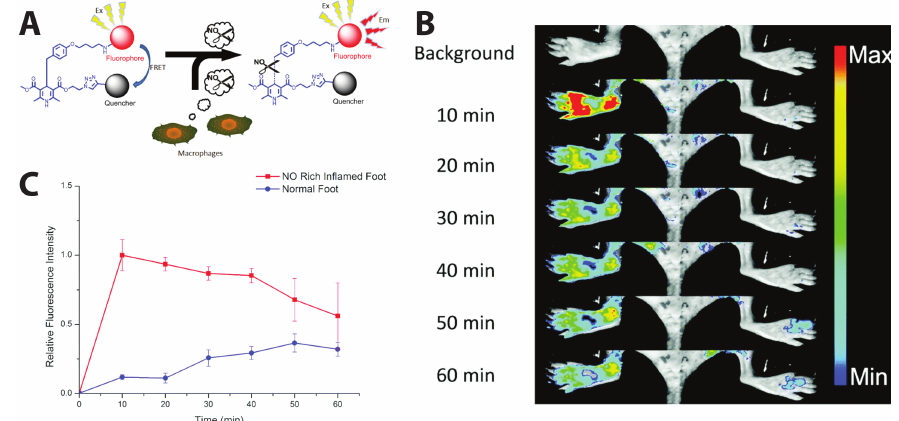
Figure 6. In vivo monitoring of inflammation-associated NO concentration. ( A ) Schematic of NO sensor. ( B ) Left foot treated with Freund’s adjuvant to induce inflammation; right foot is the inflammation-free control. ( C ) Comparison of the relative fluorescent intensity in the NO-rich inflamed foot and normal foot after intravenous injection of the probe. An 8-fold higher fluorescence intensity was observed in the inflamed area compared to the control area within 10 min post injection. Fluorescence signals were collected at 600 nm after 470 nm excitation. Reprinted from [114]. Distributed under a Creative Commons Attribution 3.0 Unported License (CC BY